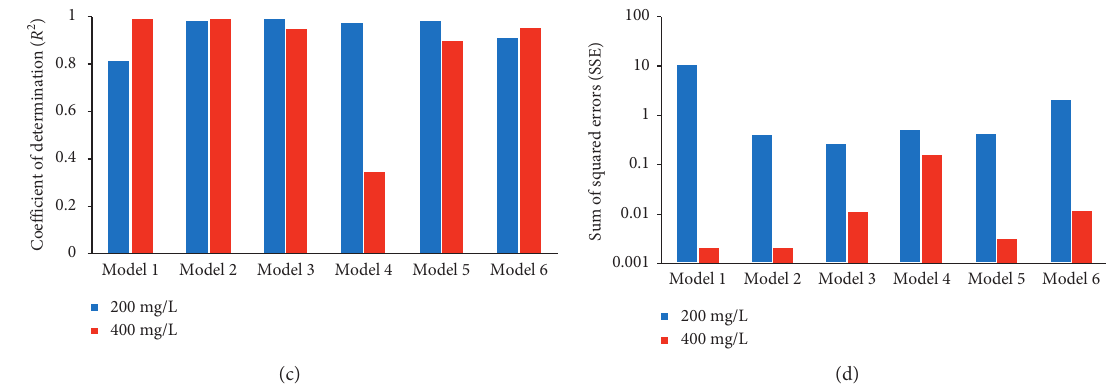
Figure 4: Scatter diagram with related statistical measures of numerical kinetic models for sorption kinetic data of nickel ions-CKD interaction. (a) C o � 200 mg/L. (b) C o � 400mg/L. (c) R 2 . (d)